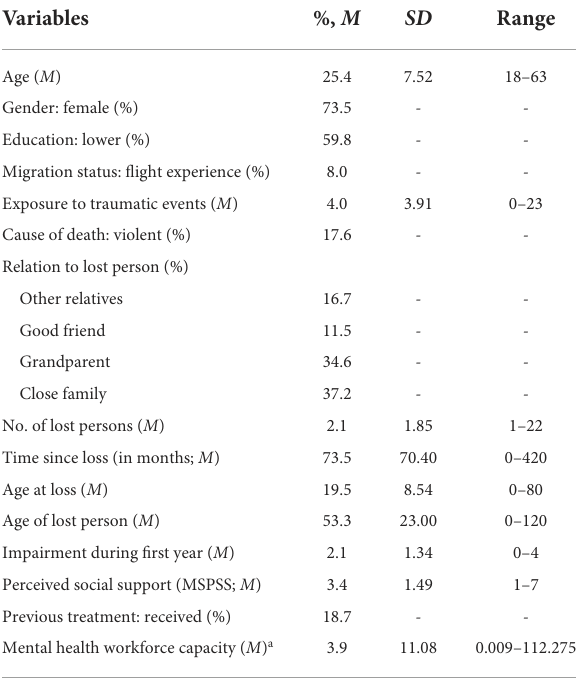
TABLE 1 Demographic, loss-, trauma-, and support-related variables of participants.